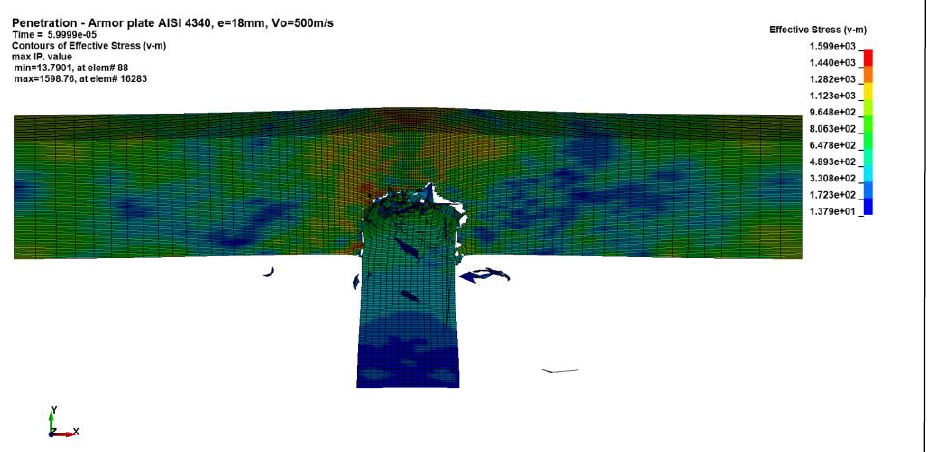
Figure 26 – Von Misses equivalent stress, time of analysis 0.06 ms – Model 4 Рис. 26 – Von Misses эквивалентное напряжение, время анализа 0.06 ms – Модель 4 Слика 26 – Von Misses-ов еквивалентни напон, време анализе 0,06 ms – модел 4